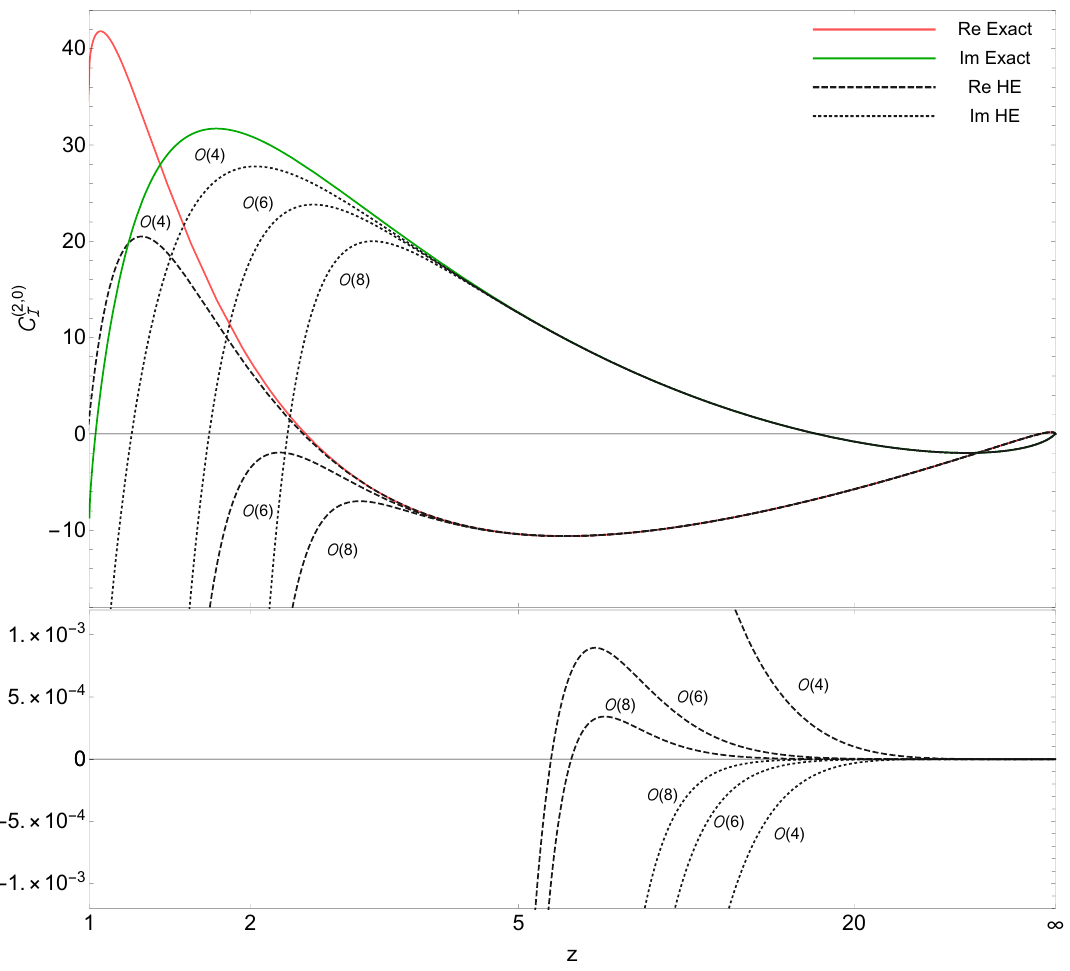
(cid:0) (cid:1) (cid:0) (cid:1) 1 =z 4 , O 1 =z 6 and at n l = 0, I